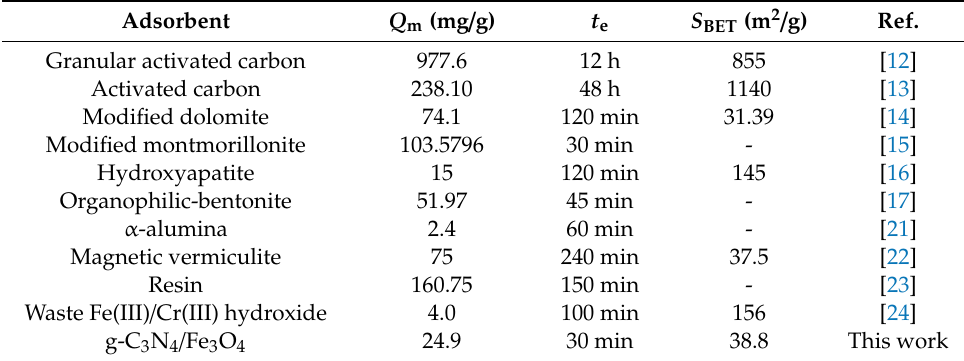
Table 5. Comparison of the adsorption performances of di ff erent adsorbents for catechol. Adsorbent Q m (mg / g) t e S BET (m 2 / g)